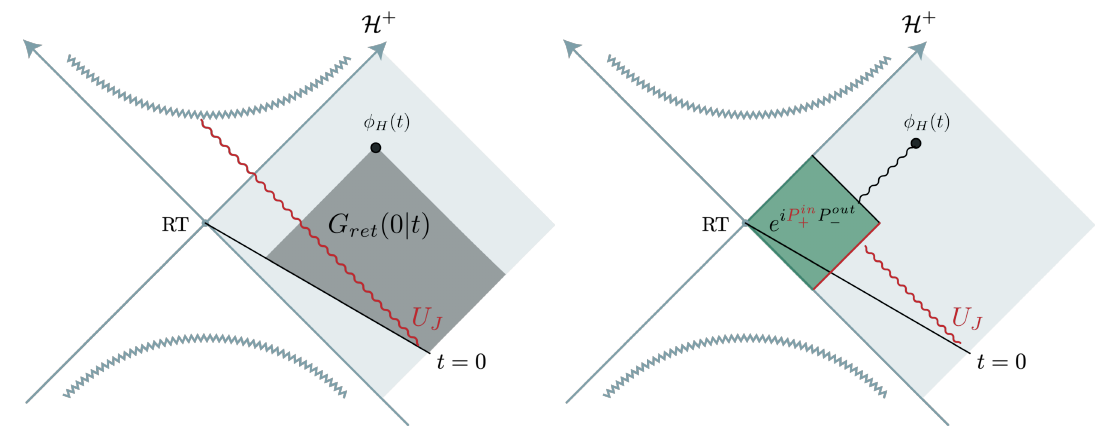
Figure 5. Free field vs shock contributions to the modular flow of a local “atmosphere” operator φ in the state